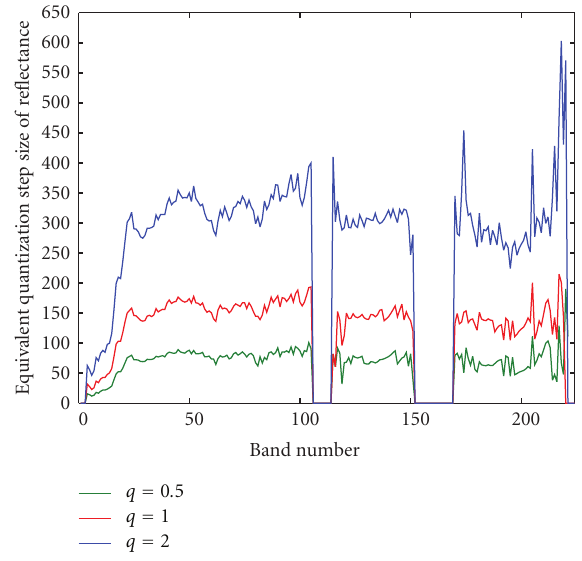
Figure 7: Equivalent quantization step sizes of reflectance values corresponding to step sizes of radiance data in Figure